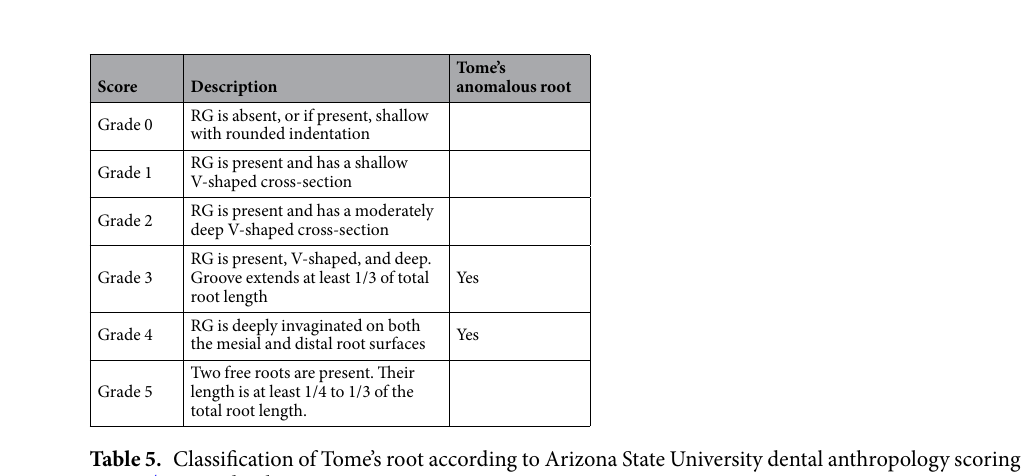
Figure 3. Illustration showing the categories of root canal morphologies in human permanent teeth according to the method by Vertucci 21 .